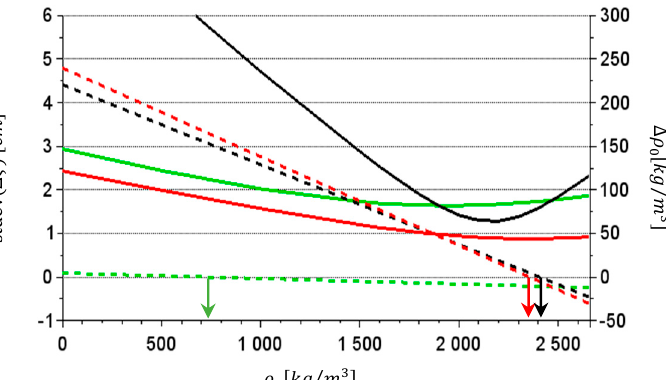
Figure 3. Standard deviations of differences ∆ ζ = ζ GGI − ζ m (solid lines) and ∆ ρ 0 = ρ mean − ρ 0 values (dotted lines) as functions of reference densities ρ 0 for the following versions: airborne-only (green), terrestrial-only (black), and combined (red). ρ 0 values for each version are marked by arrows.